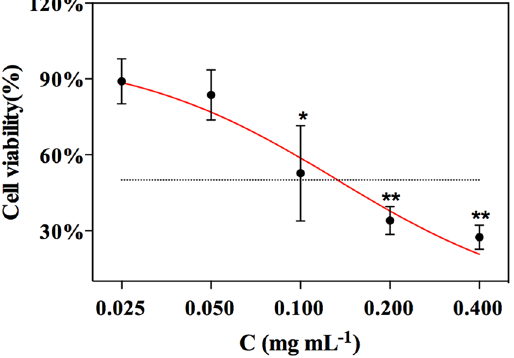
Figure 7. The MTT assay for cell variability on FGFR4 cell. Each value represented the mean ± SD, n = 3. Differences between groups were assessed by one-way ANOVA, * p < 0.05, ** p < 0.01 vs. control group.